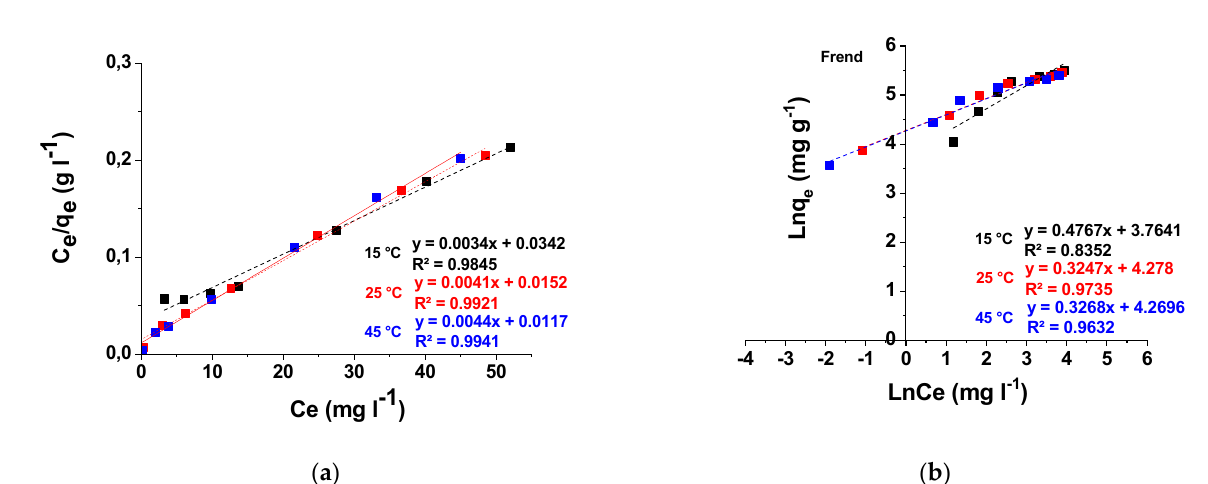
Figure 8. Adsorption isotherms of Az dye on Ni/Zn LDH nanohybrid for two models: ( a ) Langmuir and ( b ) Freundlich model. Table 3. Langmuir and Freundlich constants for Az adsorption onto Ni/Zn LDH